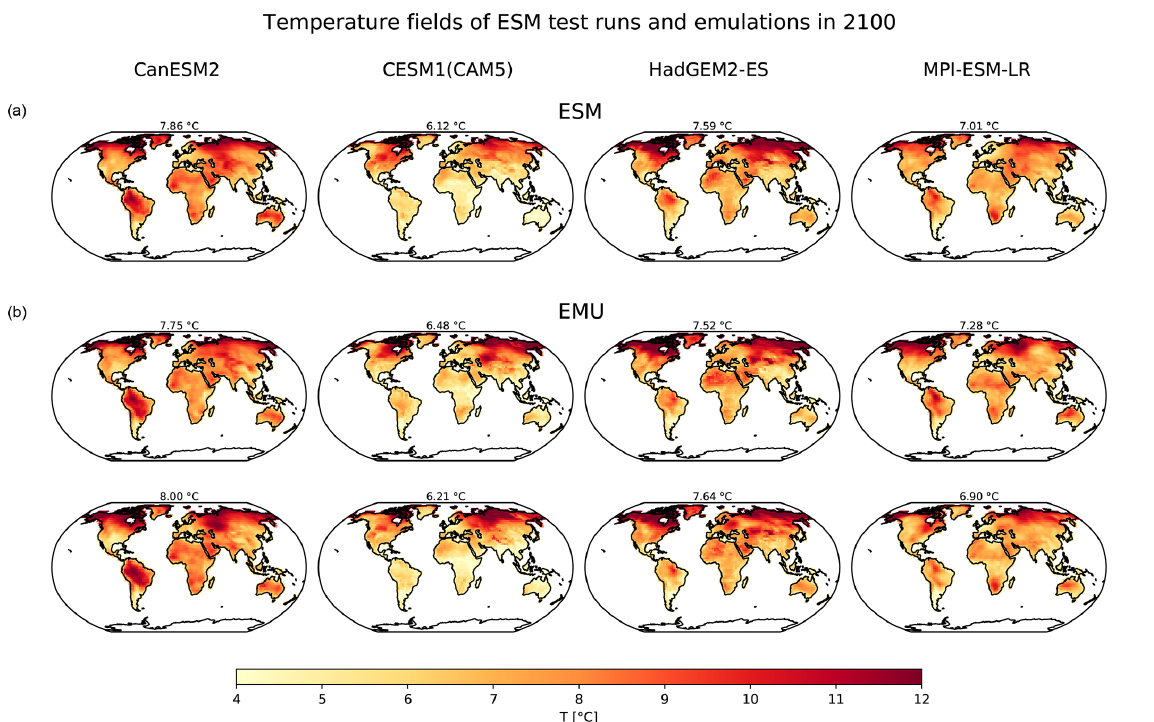
Figure 4. Temporal snapshots depicting temperature field realizations in 2100 (rows) for four example ESMs (columns). (a) One ESM field from a test run and (b) two emulations (EMUs) are shown. The temperature on top of each map refers to the global land mean.